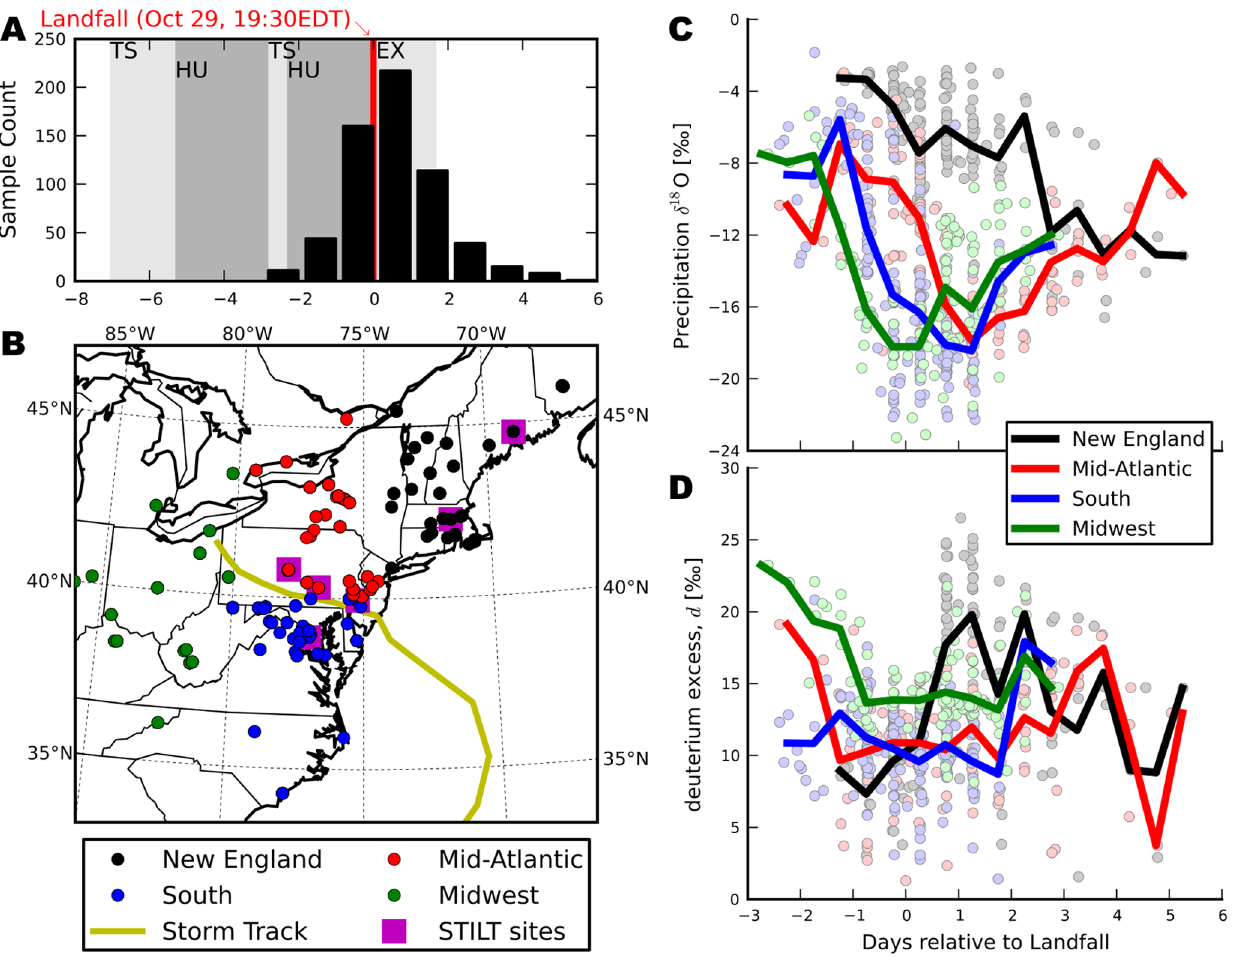
Figure 2. Spatial and temporal distribution of Sandy precipitation samples. ( A ) Histogram of the temporal distribution of collected precipitation isotope samples with NOAA classification of Sandy development: TS, Tropical Storm; HU, Hurricane; EX, Extra Tropical. ( B ) Spatial distribution of collected precipitation isotope samples by region (New England, Mid-Atlantic, Midwest, and South) with the Sandy storm track. Average regional precipitation ( C ) d 18 O and ( D ) d -excess throughout the course of the storm color-coded by region.